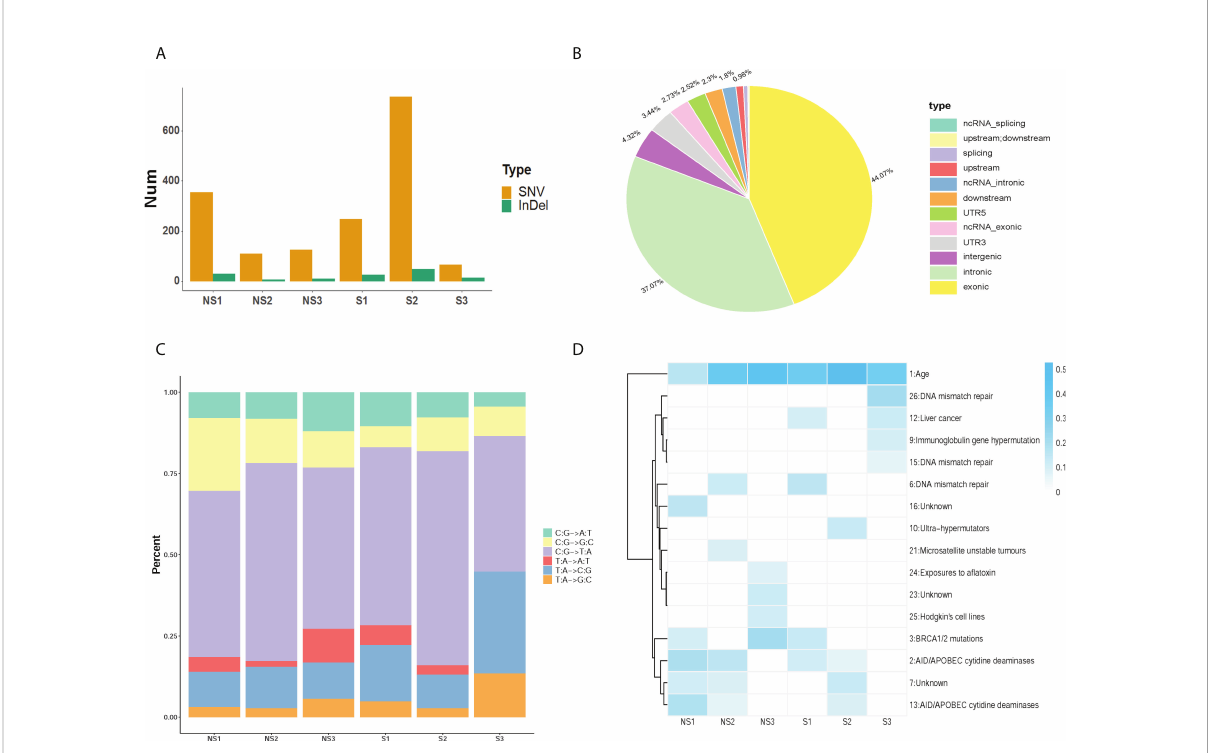
FIGURE 1 Identi fi cation of somatic mutations pro fi les in ESCC. (A) The number of SNVs and InDels was acquired in each sample. (B) The statistics of variation location in the genome in ESCC. (C) The distribution of somatic mutation type in ESCC patients. (D) The mutation signature distribution based on COSMIC signature database. Group S means the radiosensitive group and group NS means the radioresistant